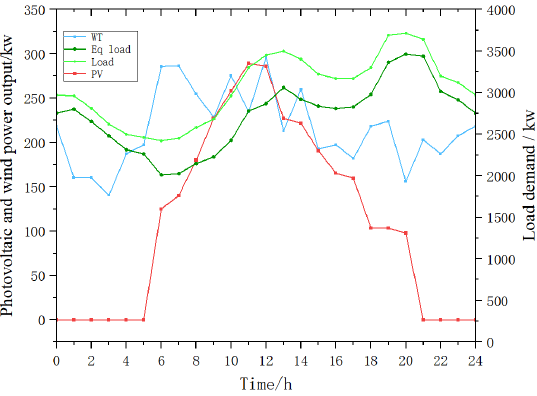
Figure 2. Comparison of the load curve and the volatile energy output.